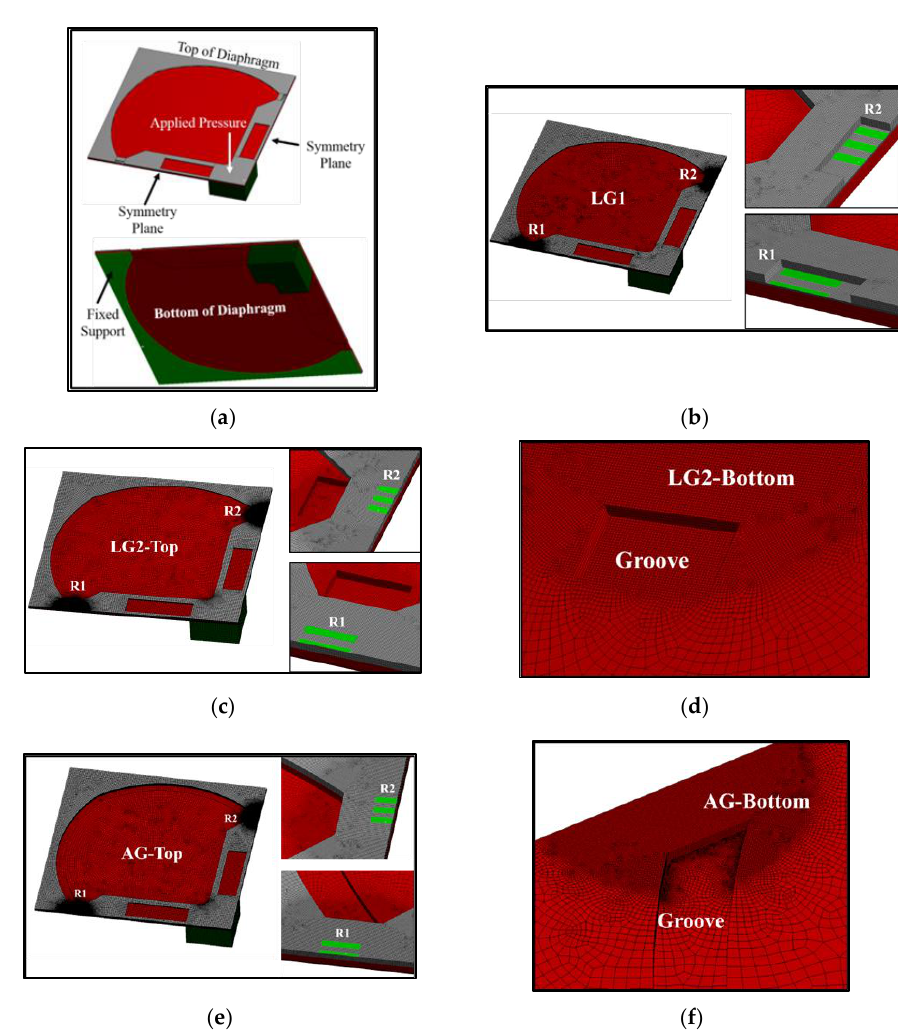
Figure 5. Computational domain for finite element analysis: ( a ) boundary conditions, ( b ) mesh dis-